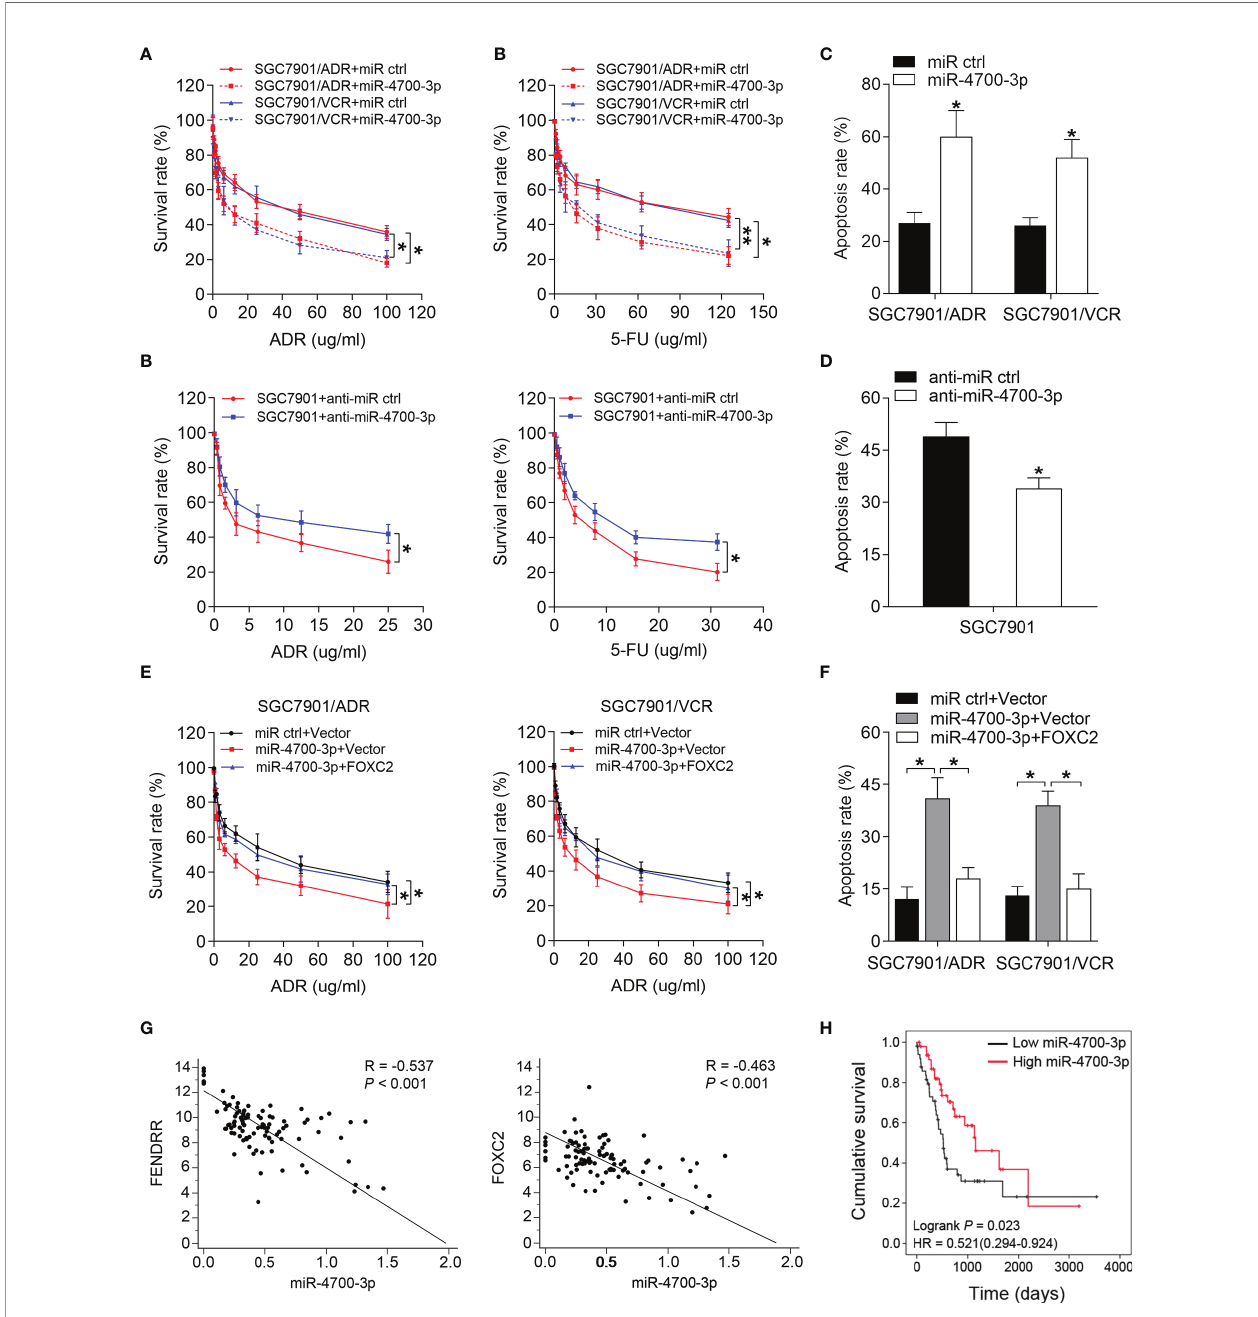
FIGURE 5 | miR-4700-3p suppresses drug resistance in GC (A, B) Survival of SGC7901/ADR and SGC7901/VCR cells transfected with miR-4700-3p mimics (A) and SGC7901 cells transfected with miR-4700-3p inhibitors or the corresponding negative controls was evaluated using the CCK-8 assay after step-up concentration of ADR and 5-FU treatment for 72 h. (C, D) The apoptotic rate of the indicated cells treated with 5-FU was shown. (E, F) SGC7901/ADR and SGC7901/VCR cells were cotransfected with miR-4700-3p, FOXC2 vector or their negative controls. Cell survival (E) and apoptosis rate (F) of the indicated cells treated with ADR or 5-FU, respectively, was evaluated. (G) Representative data extracted from TCGA datasets showing correlation between FENDRR (left) and FOXC2 (right) expression with miR-4700-3p expression in GC tissues (n=100). (H) Kaplan-Meier analysis of the correlation between miR-4700-3p expression and overall survival in GC patients included in the TCGA datasets (n=100). ** P < 0.01, * P < 0.05, error bars,